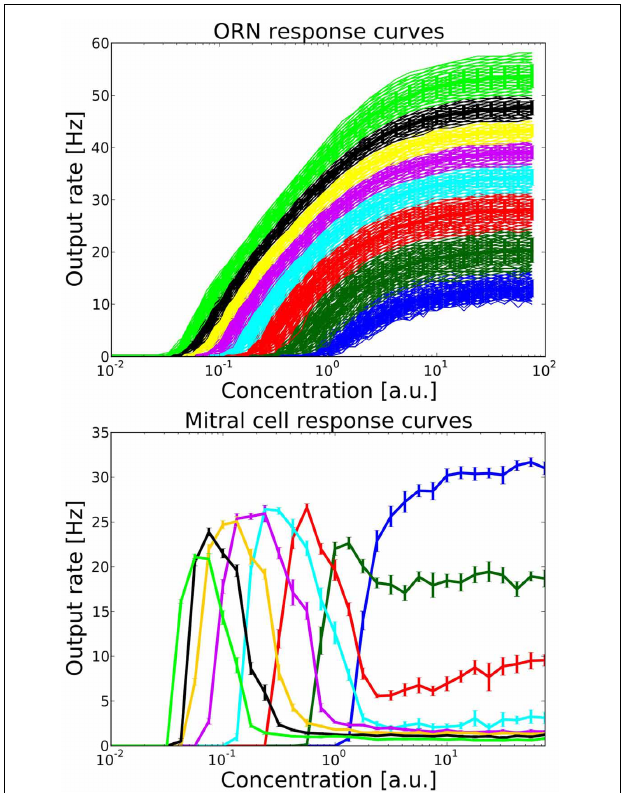
FIGURE 3 | Top: ORN response curves from one family of ORNs expressing the same OR. Colors indicate groups within this ORN family which project to different target MT and PG cells. Each group contains 100 ORNs. Output rates were measured over one simulation run of 1600ms, including the stimulation from one long sniff of ∼ 400ms Bottom: Mitral cell response curve averaged over 10 trials, error bars indicate the standard deviation. Colors correspond to the source group of ORNs providing excitatory